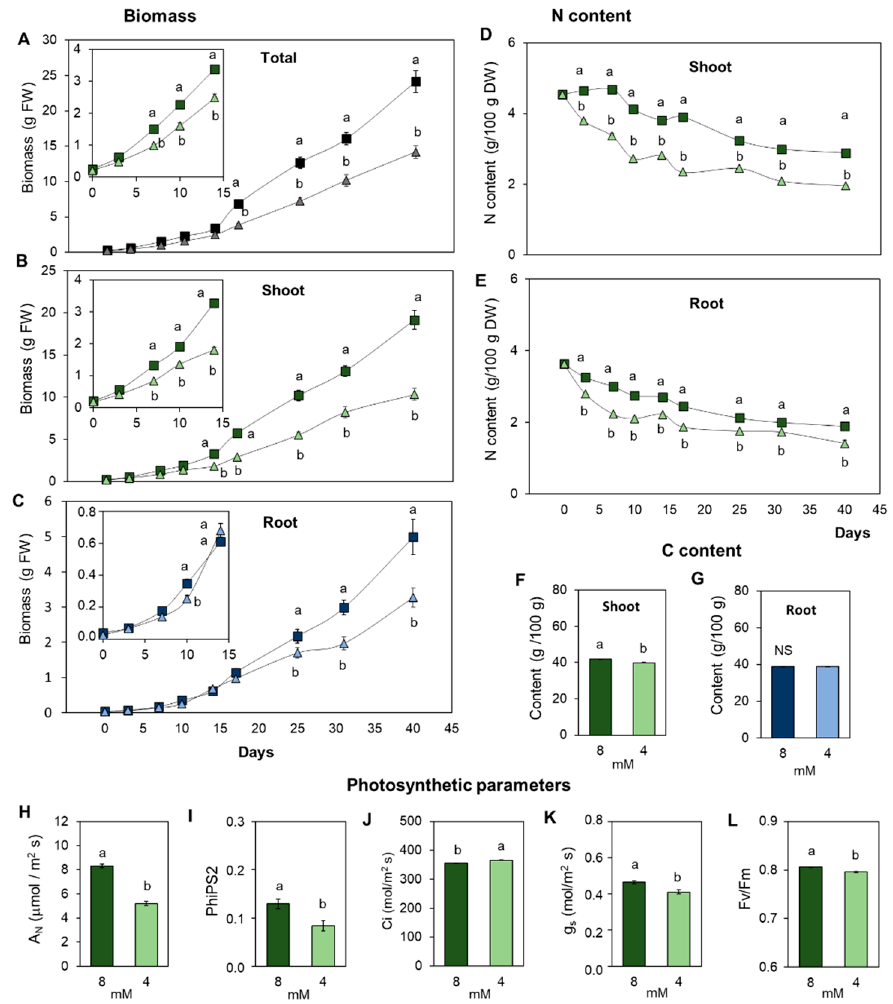
Figure 1. Effects of nitrogen supply levels on growth related parameters in tomato. Total ( A ), shoot ( B ), and root ( C ) biomass (g FW) of plants grown under optimal (8 mM N; dark colored bars) and suboptimal (4 mM N; light colored bars) conditions for 40 days. Each value in the mean of 20 to 50 plants. Data during the first 15 days are shown in the small boxes. Total nitrogen in shoots ( D ) and roots ( E ) during the 40 days is shown. Total carbon content in shoots ( F ) and roots ( G ) of plants grown at 8 and 4 mM for 20 days was determined. Values are means ( ± SE) of three independent determinations. Photosynthetic measurements were taken: ( H ) net photosynthetic rate (A N ), ( I ) effective quantum yield (PhiPS2), ( J ) substomatal CO 2 concentration (C i ), ( K ) stomatal conductance (g s ), and ( L ) maximum quantum yield (F v /F m ). Values are means ( ± SE) of ten independent determinations. For each date or determination, different letters indicate significant differences ( p < 0.05).